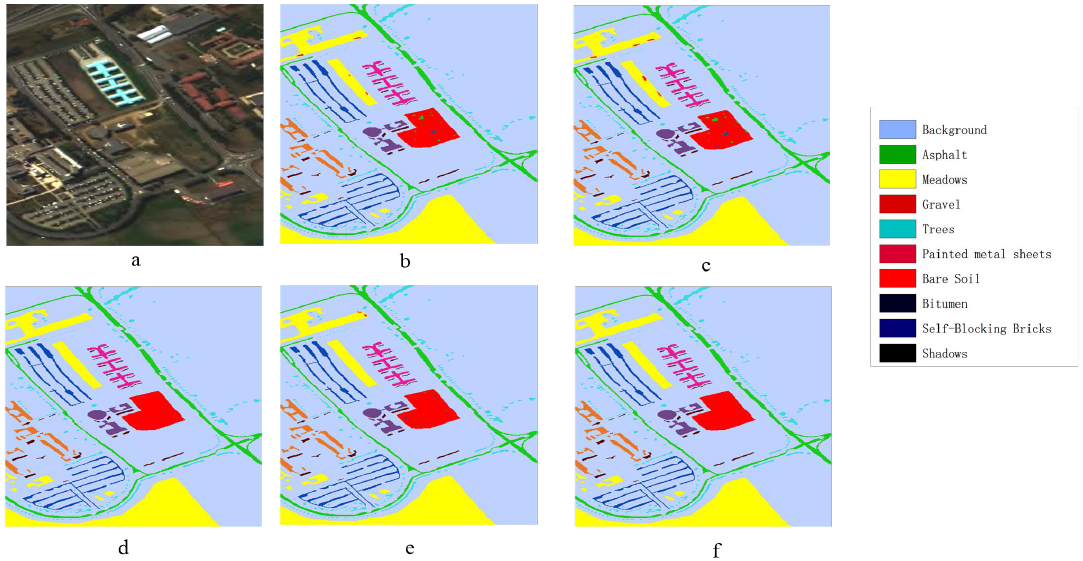
Figure 8 . The classification map for Pavia dataset. a. Study area, b. 2D-CNN, c. 3D-CNN, d. Random forest, e. Support vector machine, f. Proposed